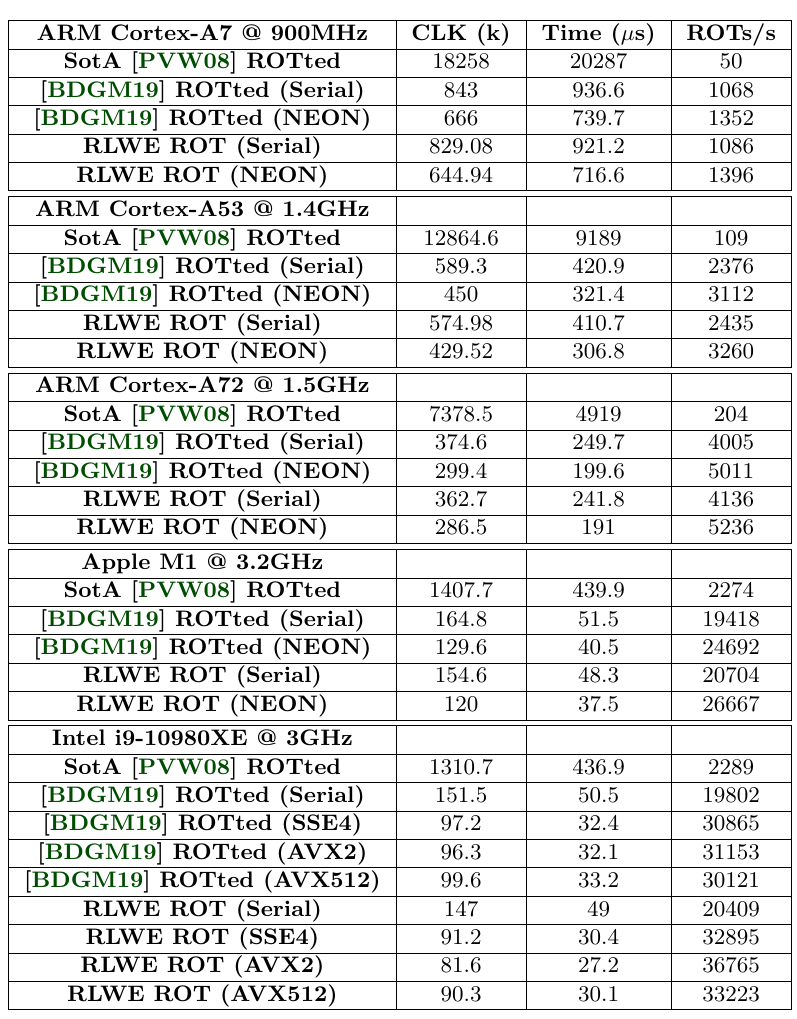
Table 3: ROT from Fig. 1 implementation results for all